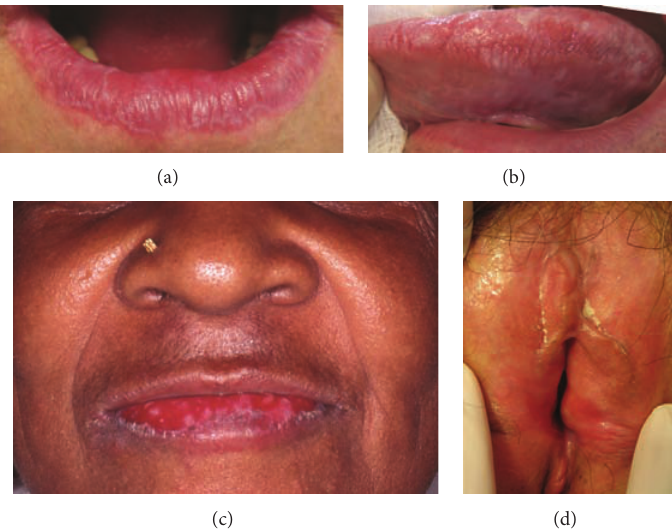
Figure 2: (a) Reticular OLP: reticulated white striae of the lower lip proper; (b) plaque-type OLP: confluent white reticulated plaques of the lateral tongue; (c) erosive OLP: superficial erosions and white striae of the lower lip proper (courtesy of Dr. Peter Lynch); (d) vulvar LP: superficial erosions at the vulvar introitus with fusion of the labia minora and vaginal stenosis; Figures 1(a) and 1(b) are reprinted with permission from [50]. OLP, oral lichen